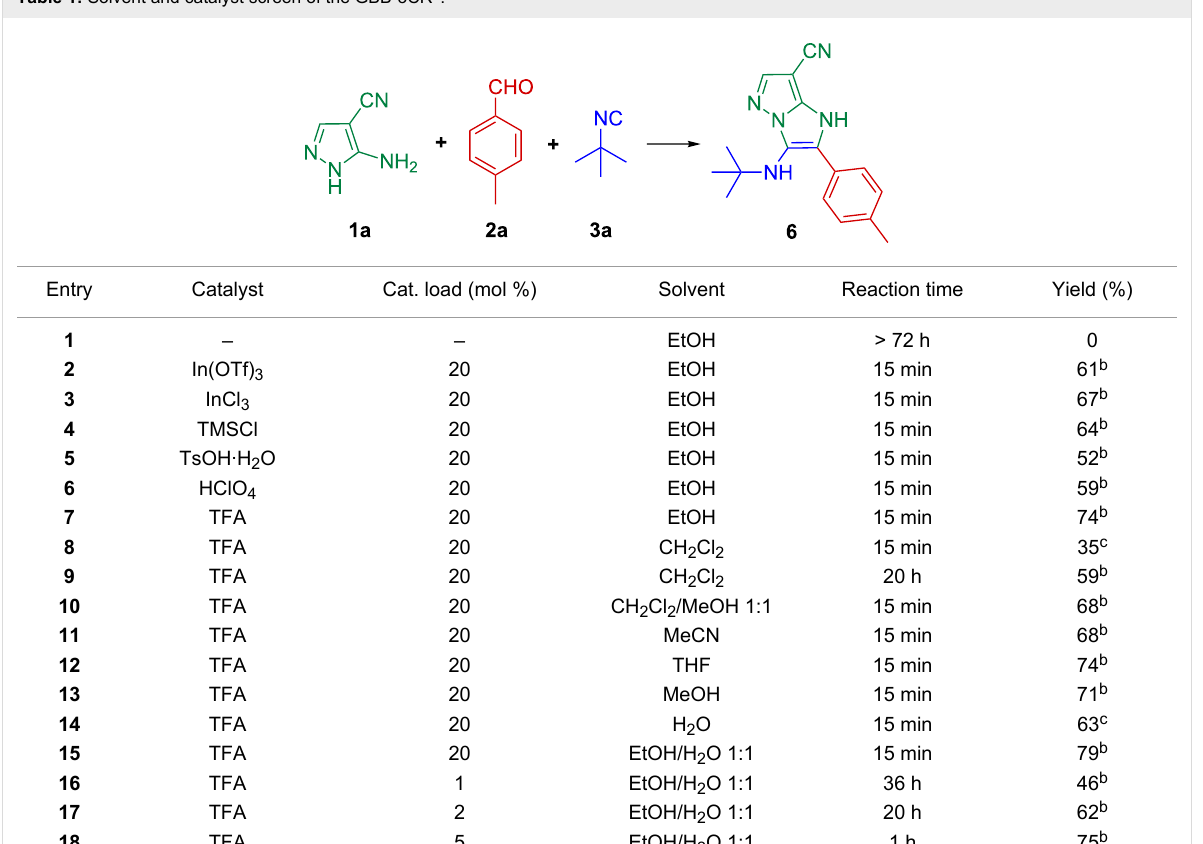
Table 1: Solvent and catalyst screen of the GBB-3CR a